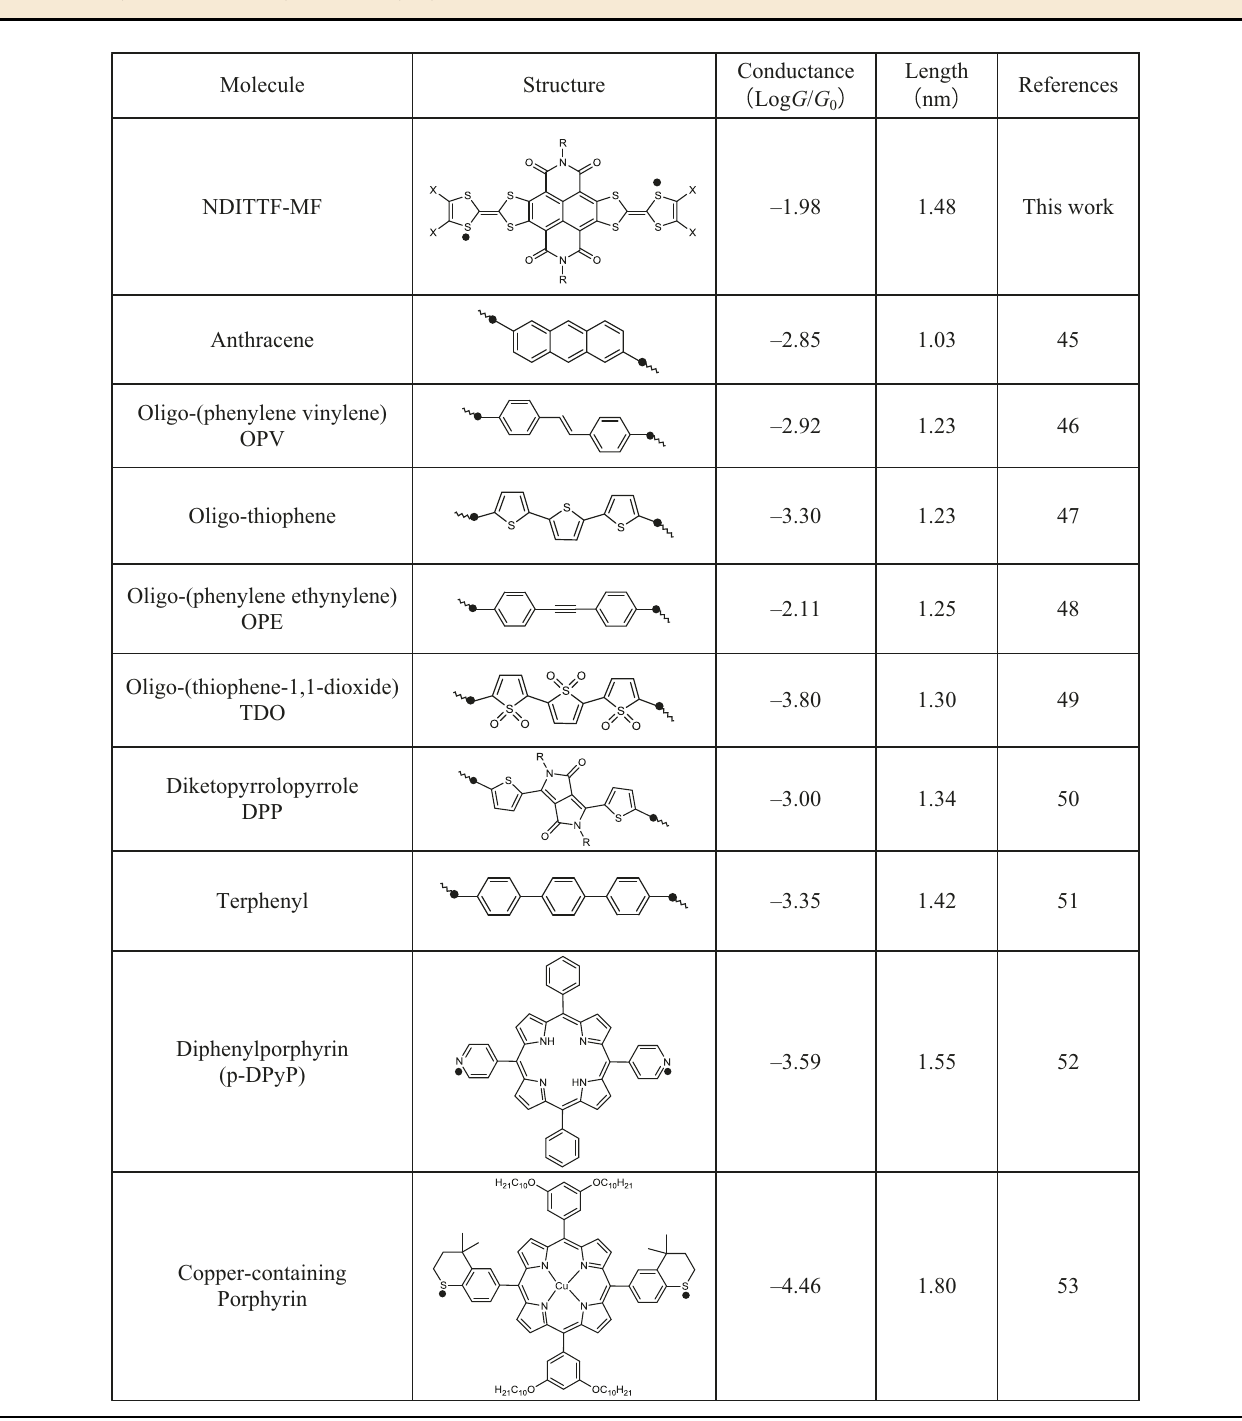
Table 1 Comparison of the reported and proposed molecular wires 45 – 53